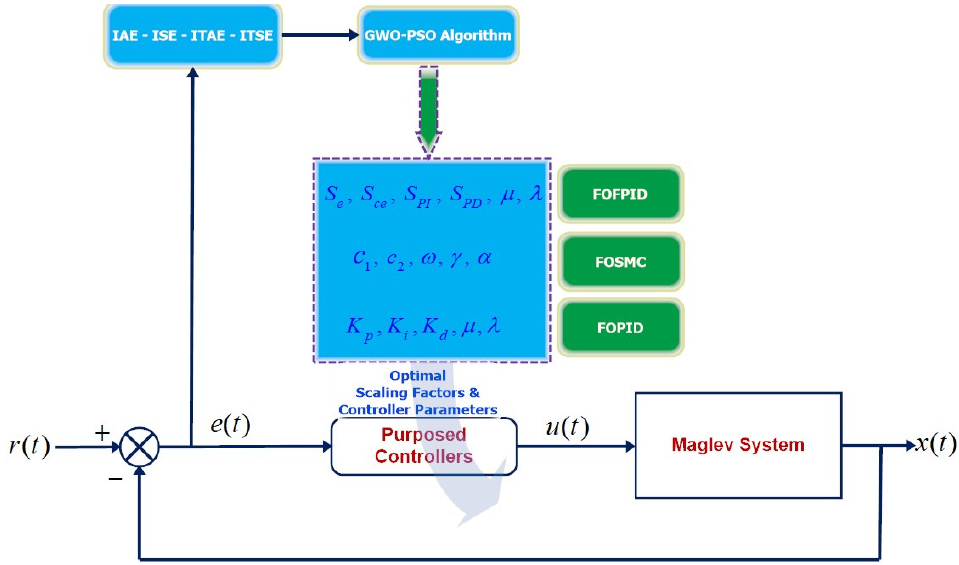
Figure 5. Block diagram of the proposed procedure used in this study.